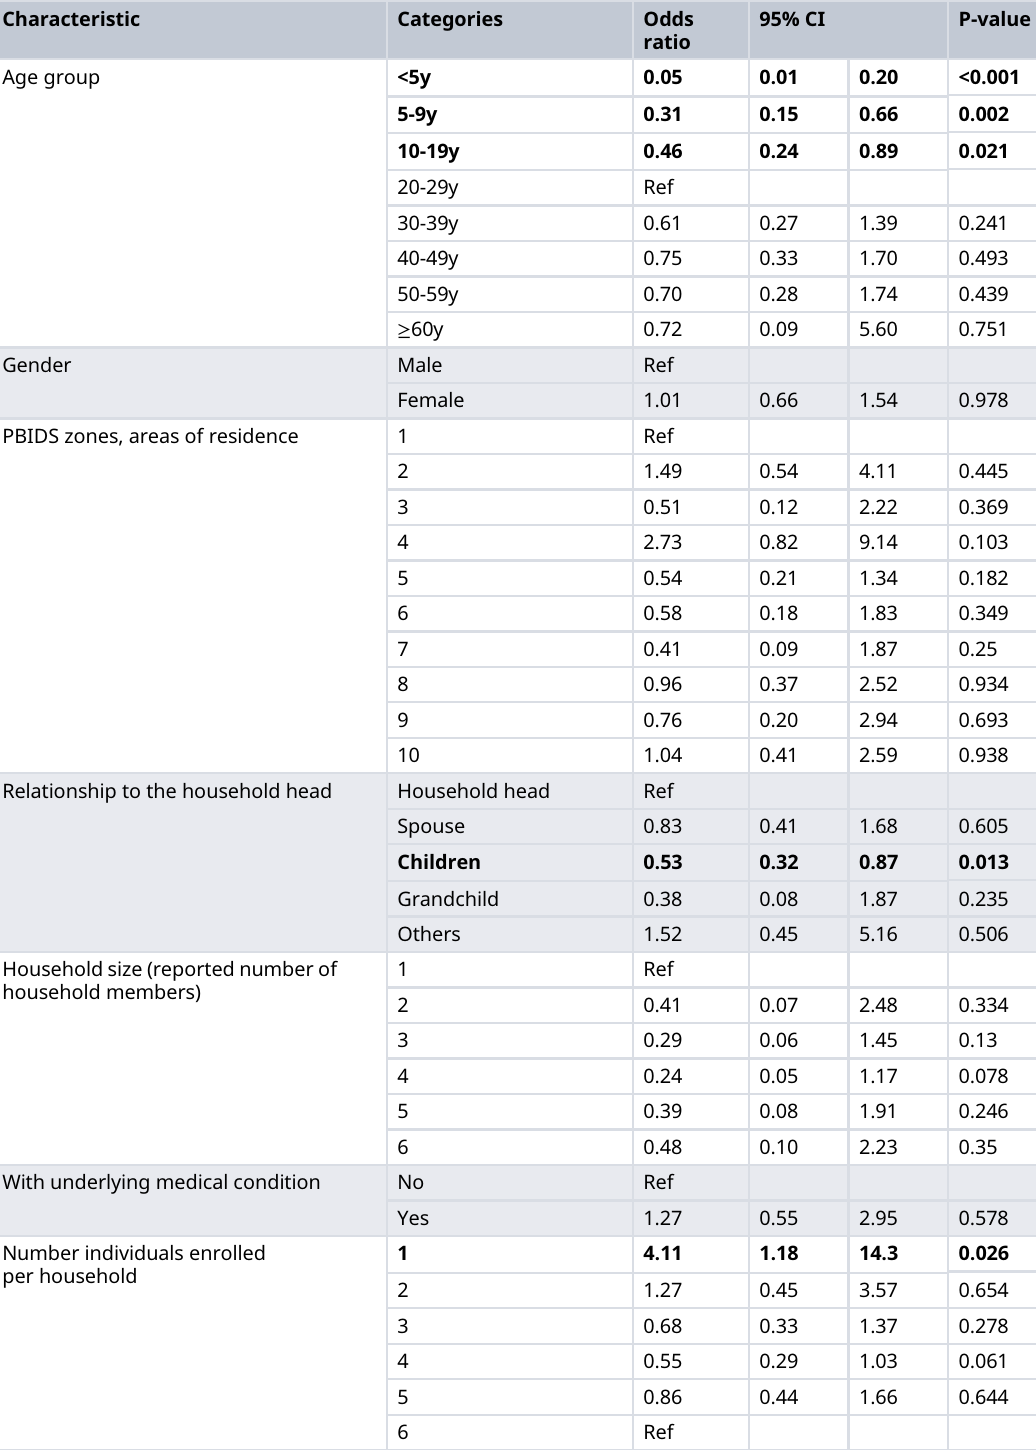
Table 3. Risk factors for individual seropositivity from univariable logistic regression model in Kibera urban informal settlement, Nairobi, Kenya.